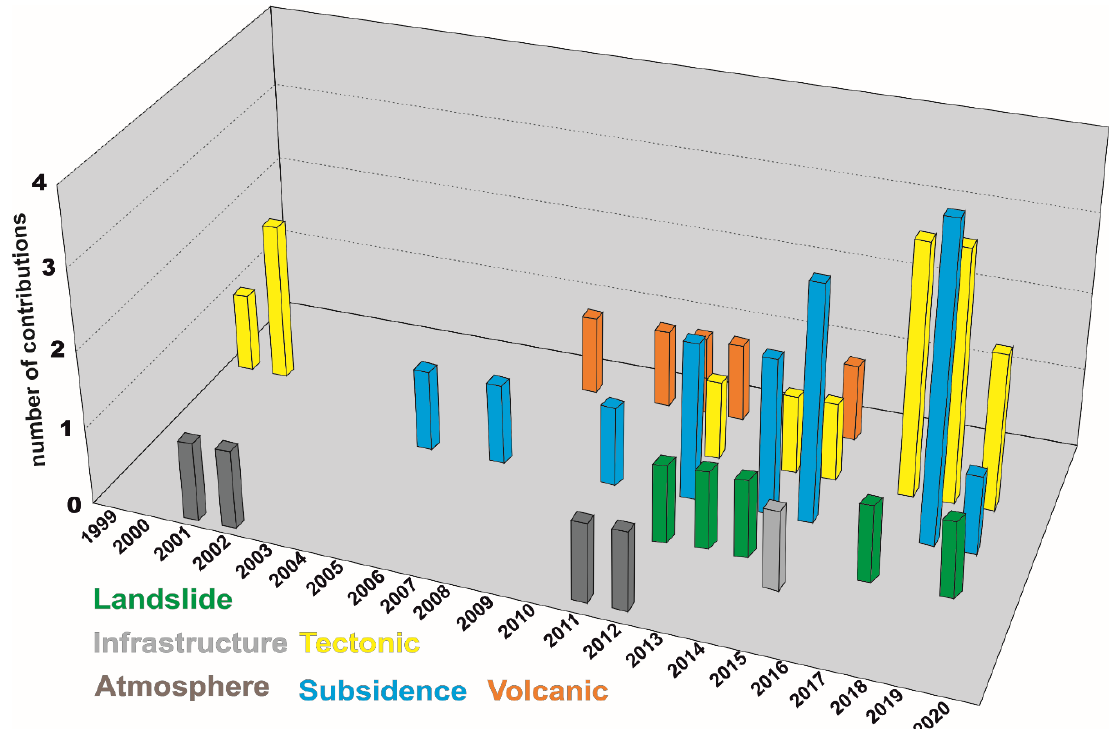
Figure 7. Temporal distribution of the scientific contribution recorded in Italy categorized according their field of application. Scientific contributions are missing for 2003, 2004, 2006, 2009, 2016, and 2020.